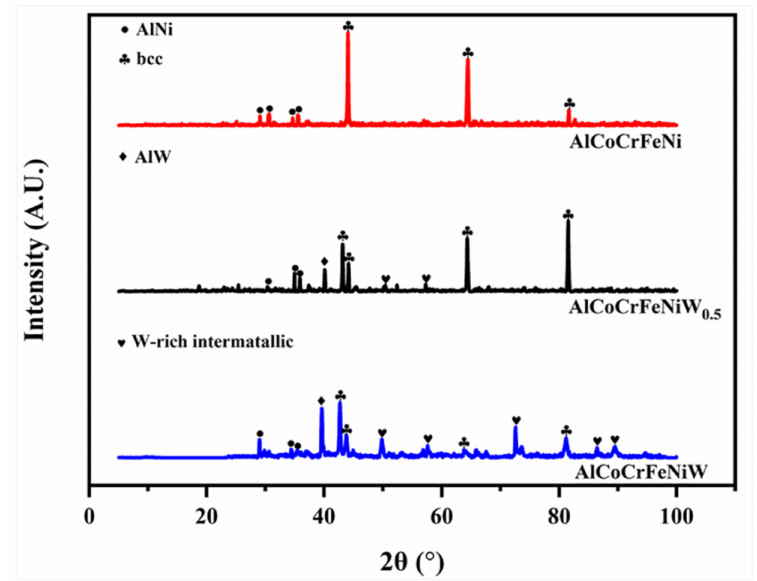
Figure 2. XRD patterns of AlCoCrFeNiW x ( x = 0, 0.5 and 1) HEA